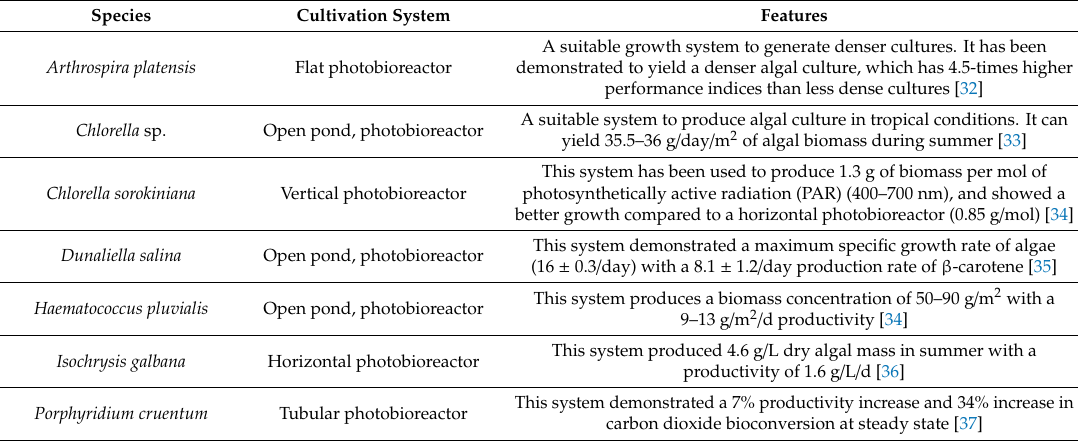
Table 2. Microalgae species and cultivation system